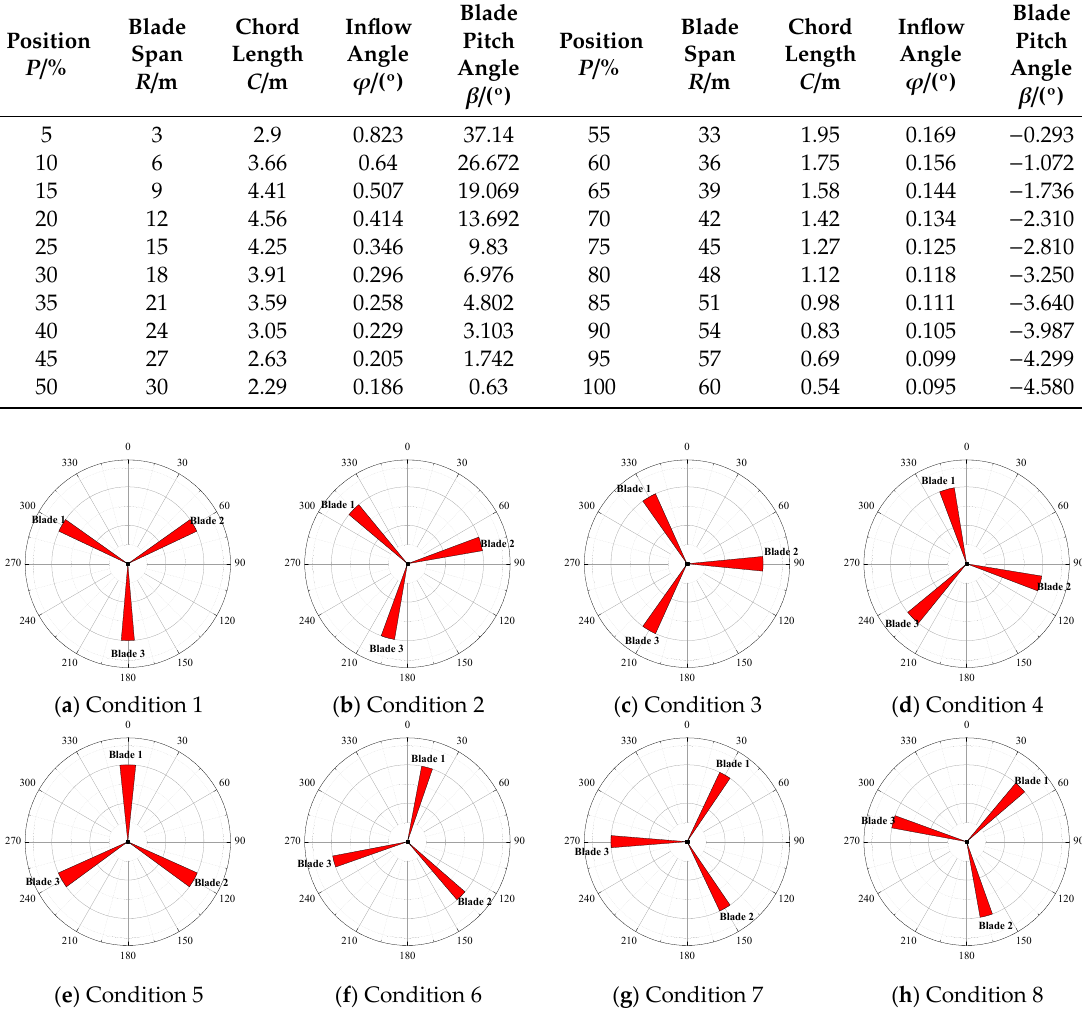
Figure 7. Single-period rotation of the blades.